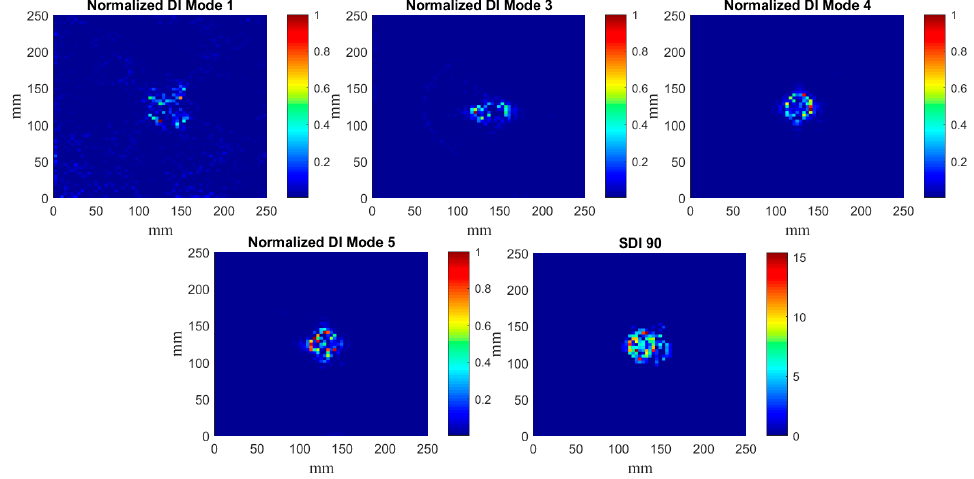
Figure 8. The determined normalized DIs for the mode shapes for the plate {1} and SDIs with the 90% confidence level.